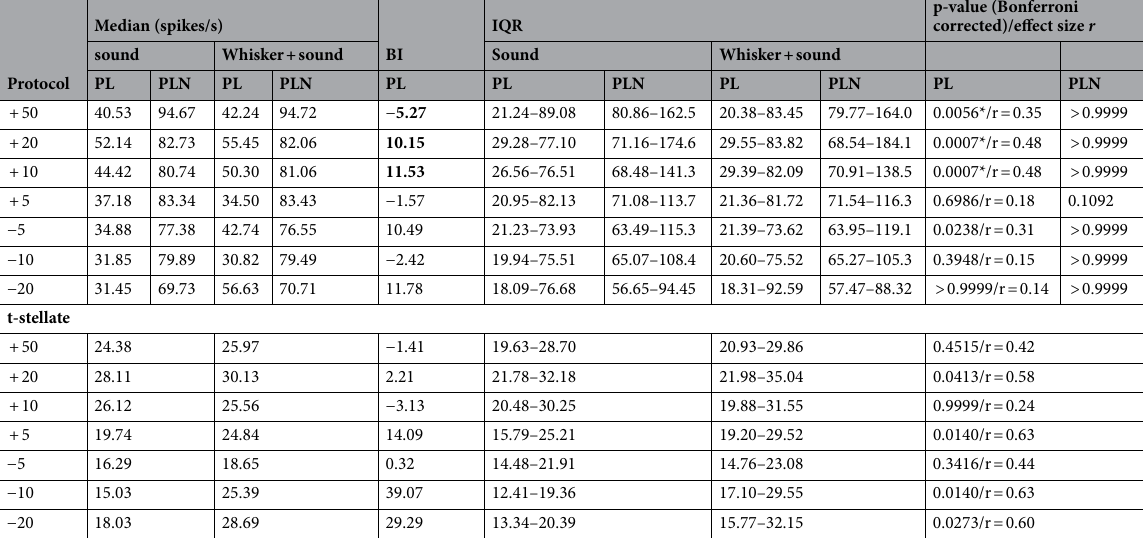
Table 2. Primary-like bushy cells and t-stellate cells in VCN. *Statistically significant changes (p < 0.01; Wilcoxon matched-pairs signed rank test and Bonferroni correction). Primary-like bushy cells (PL, n = 42 cells), Primary-like-with-notch bushy cells (PLN, n = 7) and t-stellate cells (n = 10). IQR = interquartile range. BI = bimodal integration index (mean). BI values are in bold when there was a significant change in median spiking between “sound” and “whisker + sound” stimulation. Note: 5 PL bushy cells showed an increase if the bimodal response compared to the sound only stimulation with the − 20